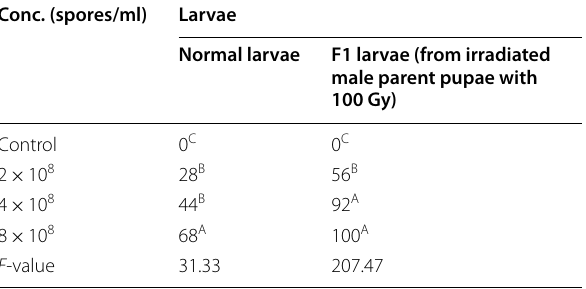
Values represent the mean of 5 replicates each of 5 larvae Means in the same column that do not share a letter are significantly different (Tukey Pairwise Comparisons)